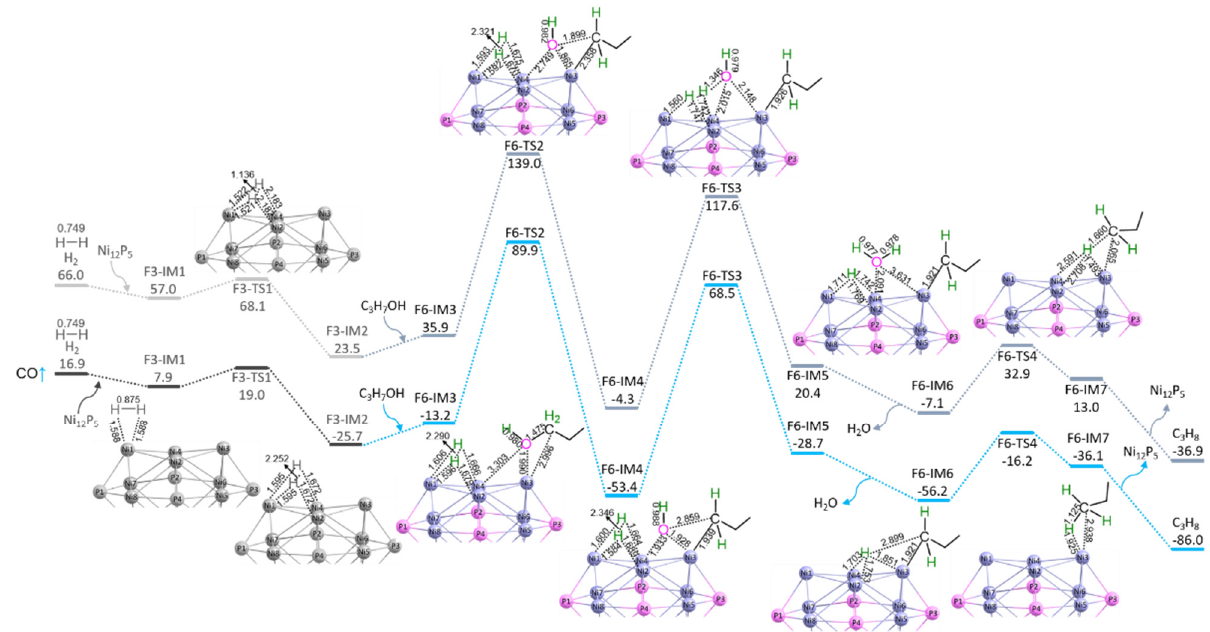
Figure 6. The potential energy curves with the relative Gibbs free energy ( G r , kJ mol − 1 ) and the geo- metric structures with bond lengths (Å) for reaction stage S6 over Ni 12 P 5 cluster at GGA − PBE/DSPP, DNP level. For brevity, some hydrogen atoms are hidden. CO ↑ shows the CO pressure with 10 − 5 atm under experimental condition.